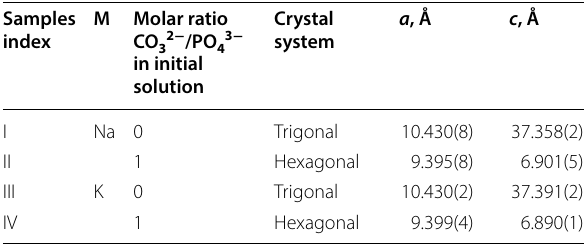
Table 1 Indexes and chemical composition of obtained samples in system M–Ca 2 + –NO